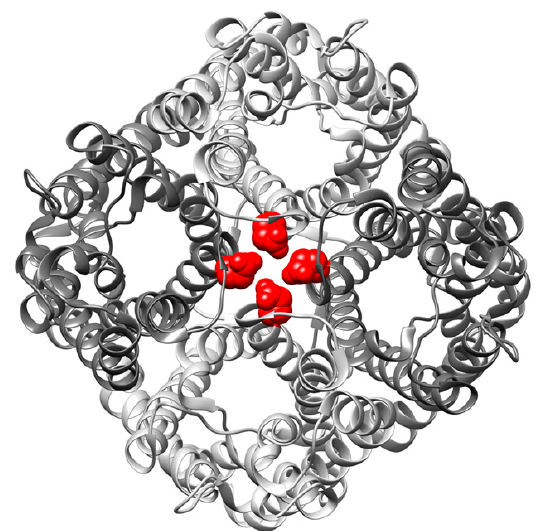
Figure 1. Top view on a GlpF tetramer with Glu 43 highlighted. The GlpF tetramer consists of four GlpF monomers (shown in different gray tones) each with a glycerol ‐ conducting pore. The residue Glu 43 (red) is located in the central pore of the GlpF tetramer (PDB ‐ ID: 1FX8). AQP tetramerization might also contribute to an increased in vivo stability, as shown for the E.